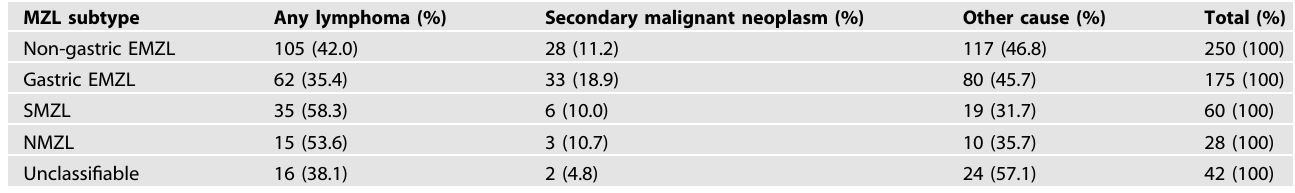
Table 4. Causes of death in patients with marginal zone